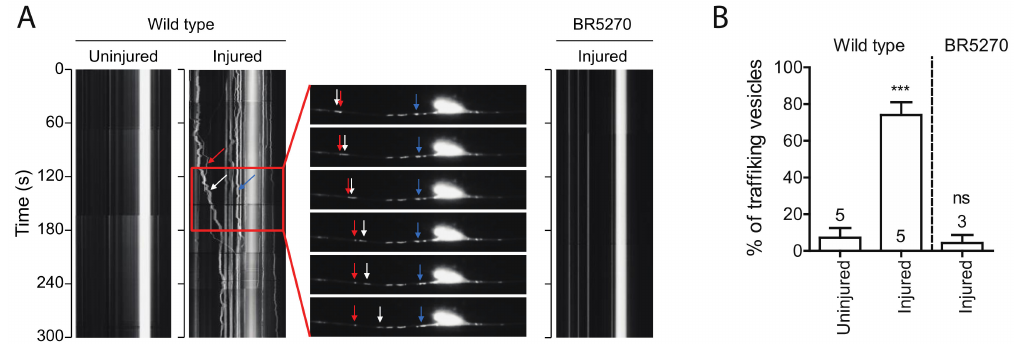
Figure 3. Injury induces autophagic vesicles tra ffi cking in wild-type animals but not in tauopathy models. ( A ) Representative kymograph of autophagic vesicles movement in touch neuron (visualized with P mec-4 -mCherry::GFP::LGG-1 reporter); each arrow (red, blue, and white) indicate autophagic vesicles on PLM axon. Kymographs were generated by Olympus IX83 software from movies taken immediately before axotomy (Uninjured) and 24 h post axotomy (injured). ( B ) Quantification of tra ffi cking % (number of tra ffi cking vesicles / total vesicles in 50 µ m region of proximal PLM axon) for experiments in ( A ). Statistics: one-way ANOVA; mean ± SEM; *** p < 0.001; ns, Not significant.